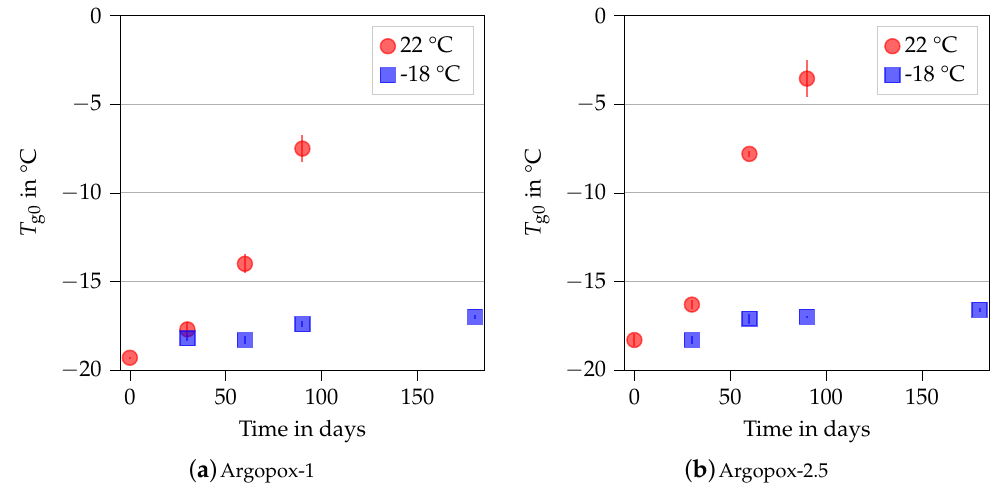
Figure 5. Glass transition temperature T g0 of the uncured Argopox-1 ( a ) and Argopox-2.5 ( b ) in dependence of the storage period at T = 22°C (red) and T = − 18°C